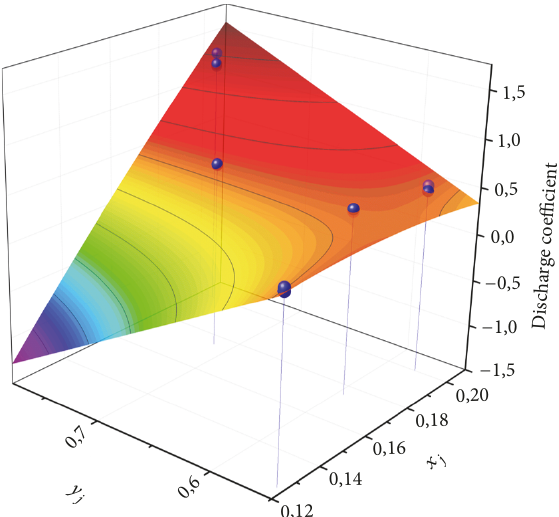
Figure 14: Surface fitting of the discharge coefficients for the long teeth with the geometrical parameters.